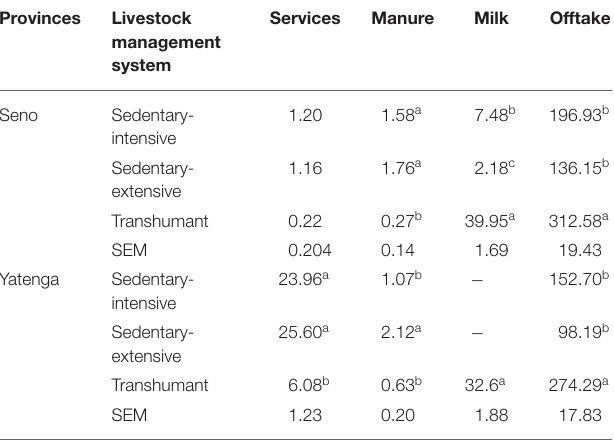
TABLE 3 | Livestock beneficial output values (US$/ household /year) in the study sites.